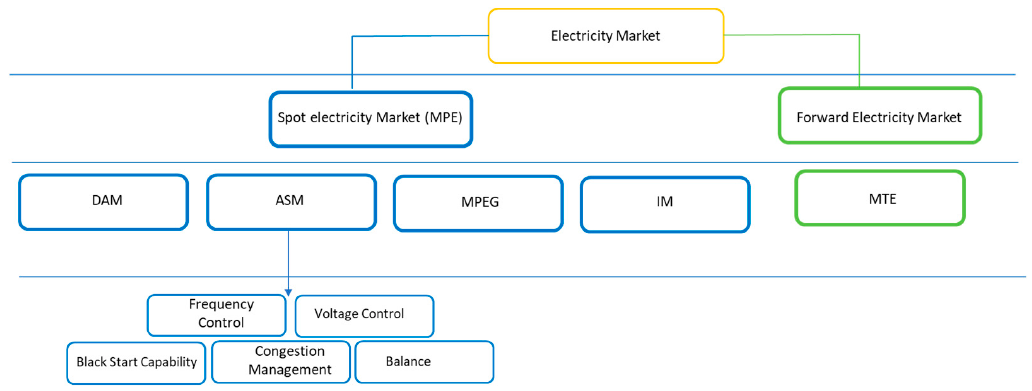
Figure 1. Italian electricity market structure .